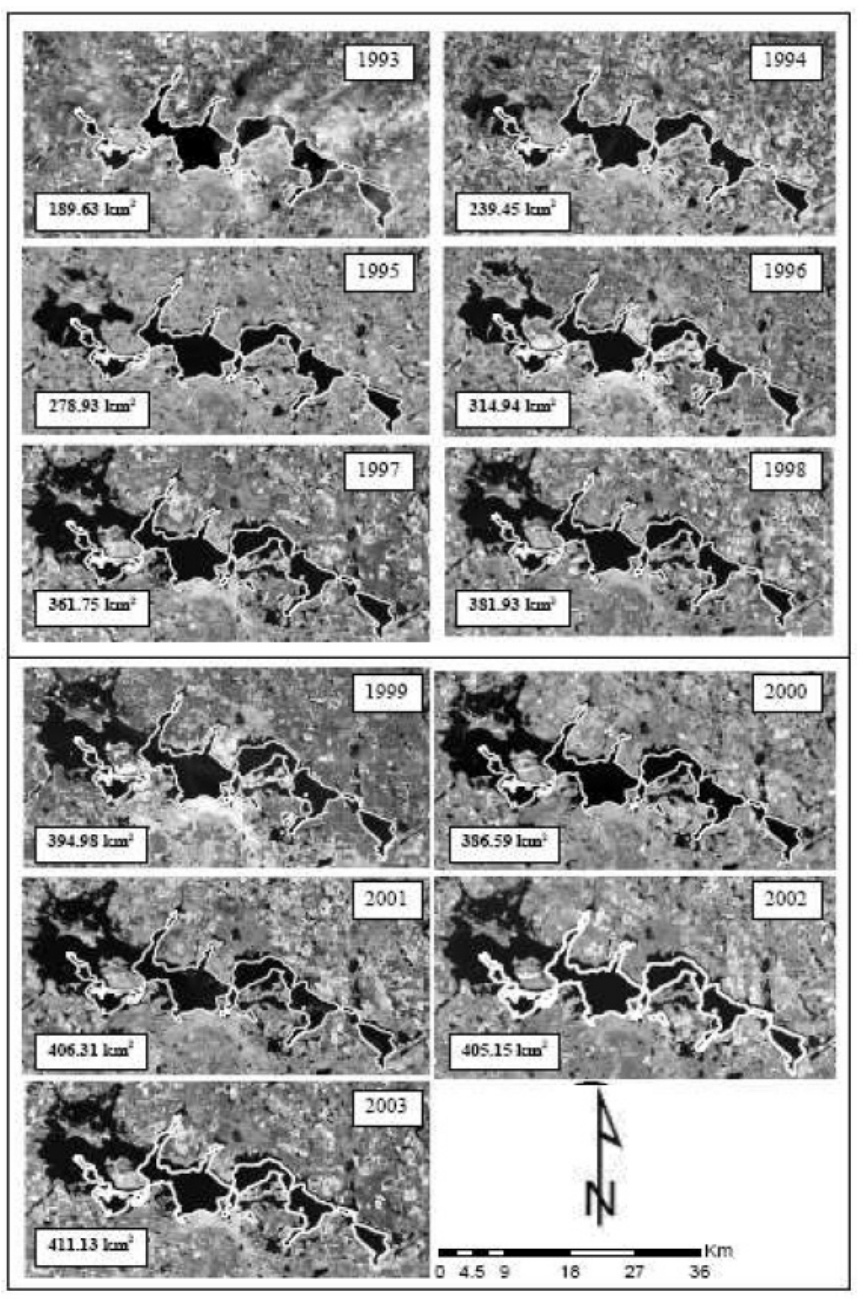
Figure 3. The spatial expansion of Devils Lake from Landsat